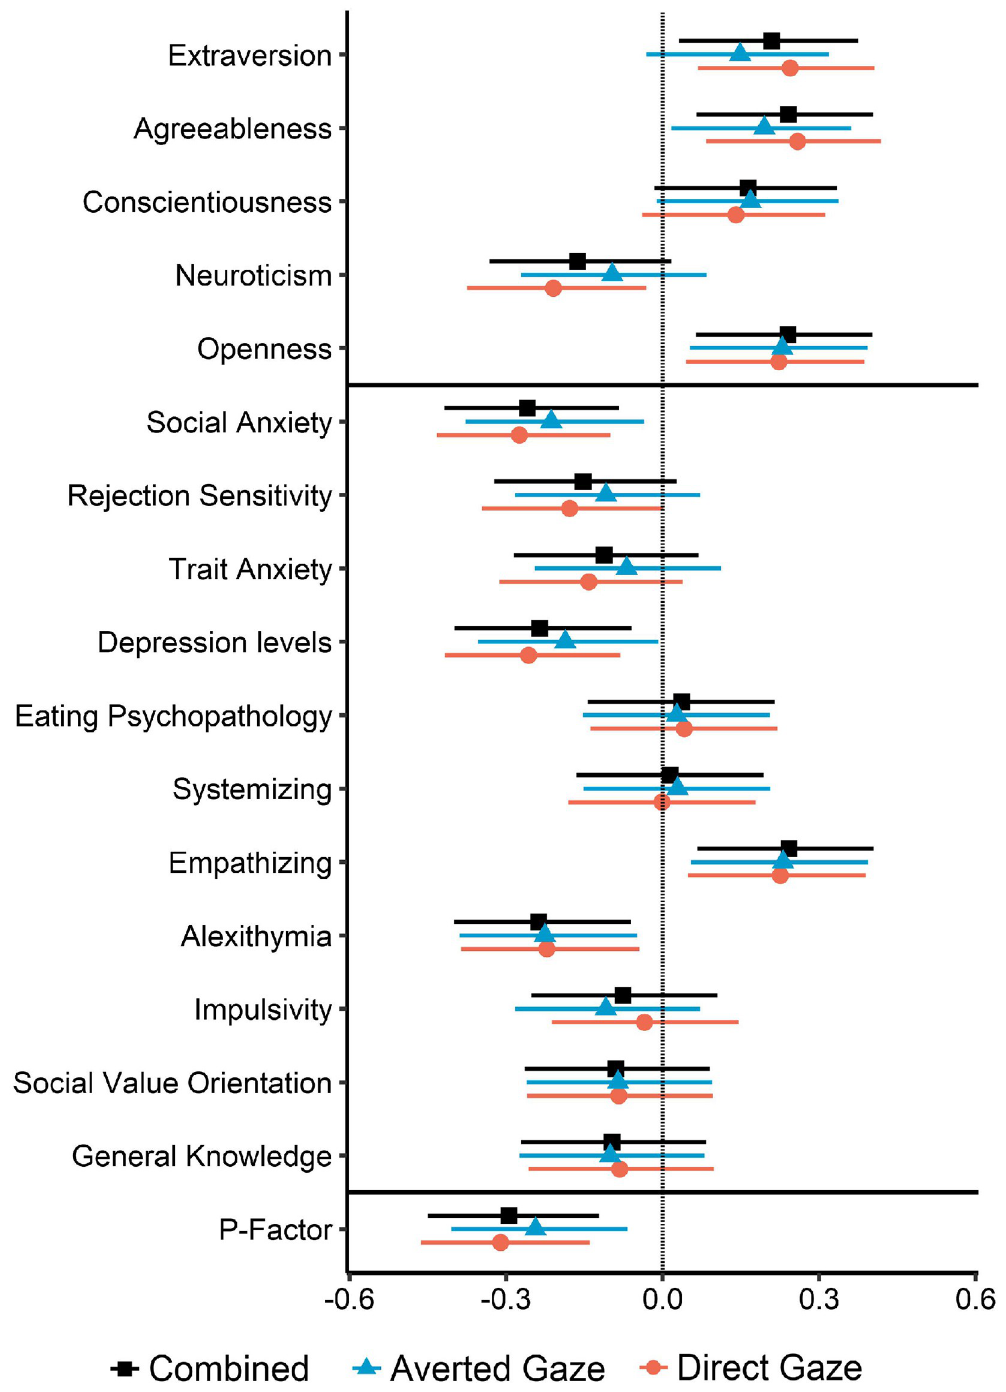
Fig 2. Correlations between attention towards faces and personality measures (above the first horizontal line), several clinical and other psychological measures as well as a general psychopathology factor ( p -factor, lowest line). Results are presented for attention to faces across all 20 images as well as for only the 10 images depicting averted and direct gaze, respectively. Error bars represent 95%-CIs.